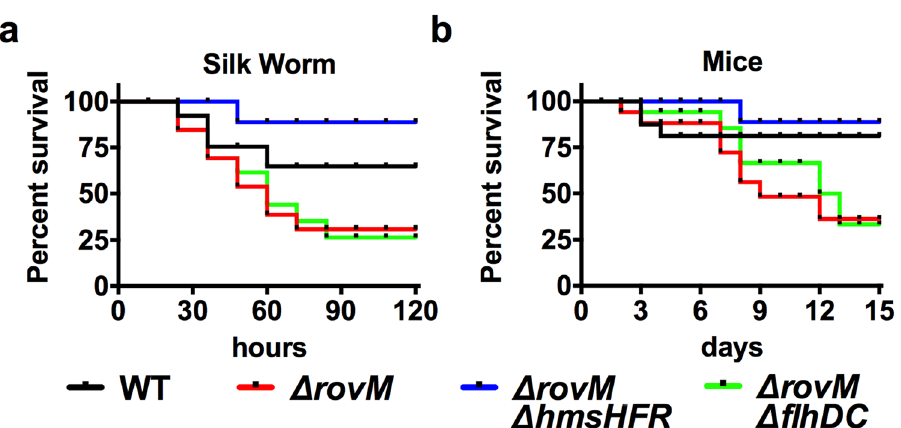
Figure 5. RovM attenuates bacterial virulence by repressing hms expression. ( a ) Bacterial strains grown in M9 were washed twice in sterilized PBS and injected into larval silkworm. 5 × 10 8 bacteria were applied to different groups of larvae (n = 25/strain), and the survival rate was monitored every 12 h for 6 days. ( b ) The same bacteria were used for orogastric infection of 6–8 weeks old female C57BL/6 mice. For survival assays 3 × 10 9 bacteria of each strain were applied to different groups of mice (n = 10/strain), and the survival rate of the mice was determined by monitoring the survival daily for 3 weeks. Similar results were obtained in three independent experiments, and data shown are from one representative experiment done in triplicate.